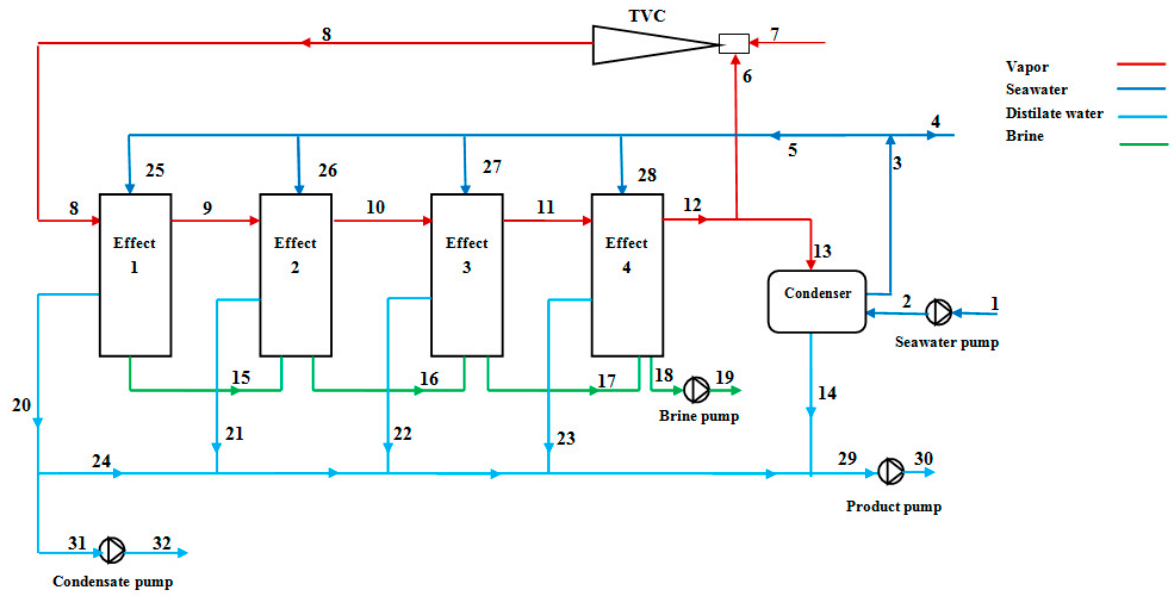
Figure 1. Schematic diagram of the MED-TVC desalination system with parallel cross feed config- uration.